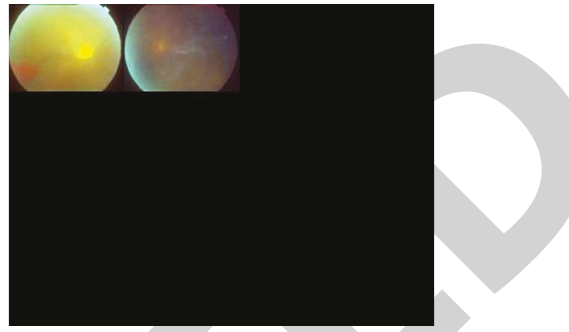
Figure 3: Fundus photo of right eye and left eye showing vitreous